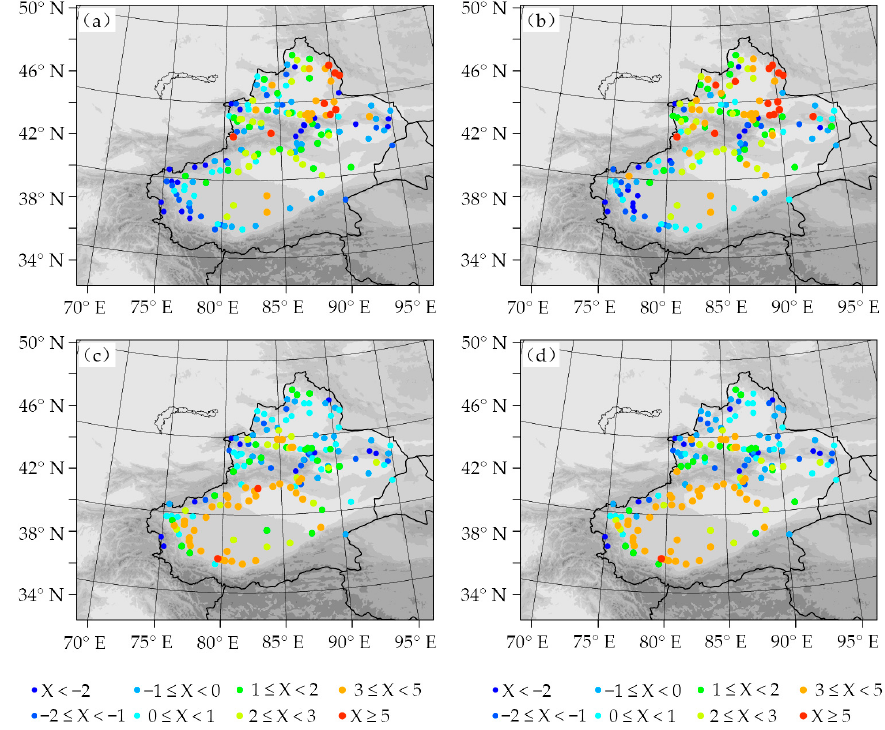
Figure 8. Monthly ME of simulated 2-m air temperature in January ( a , b ) and July ( c , d ) 2017 with Noah ( a , c ) and Noah-MP scheme ( b , d ) (unit: °C).